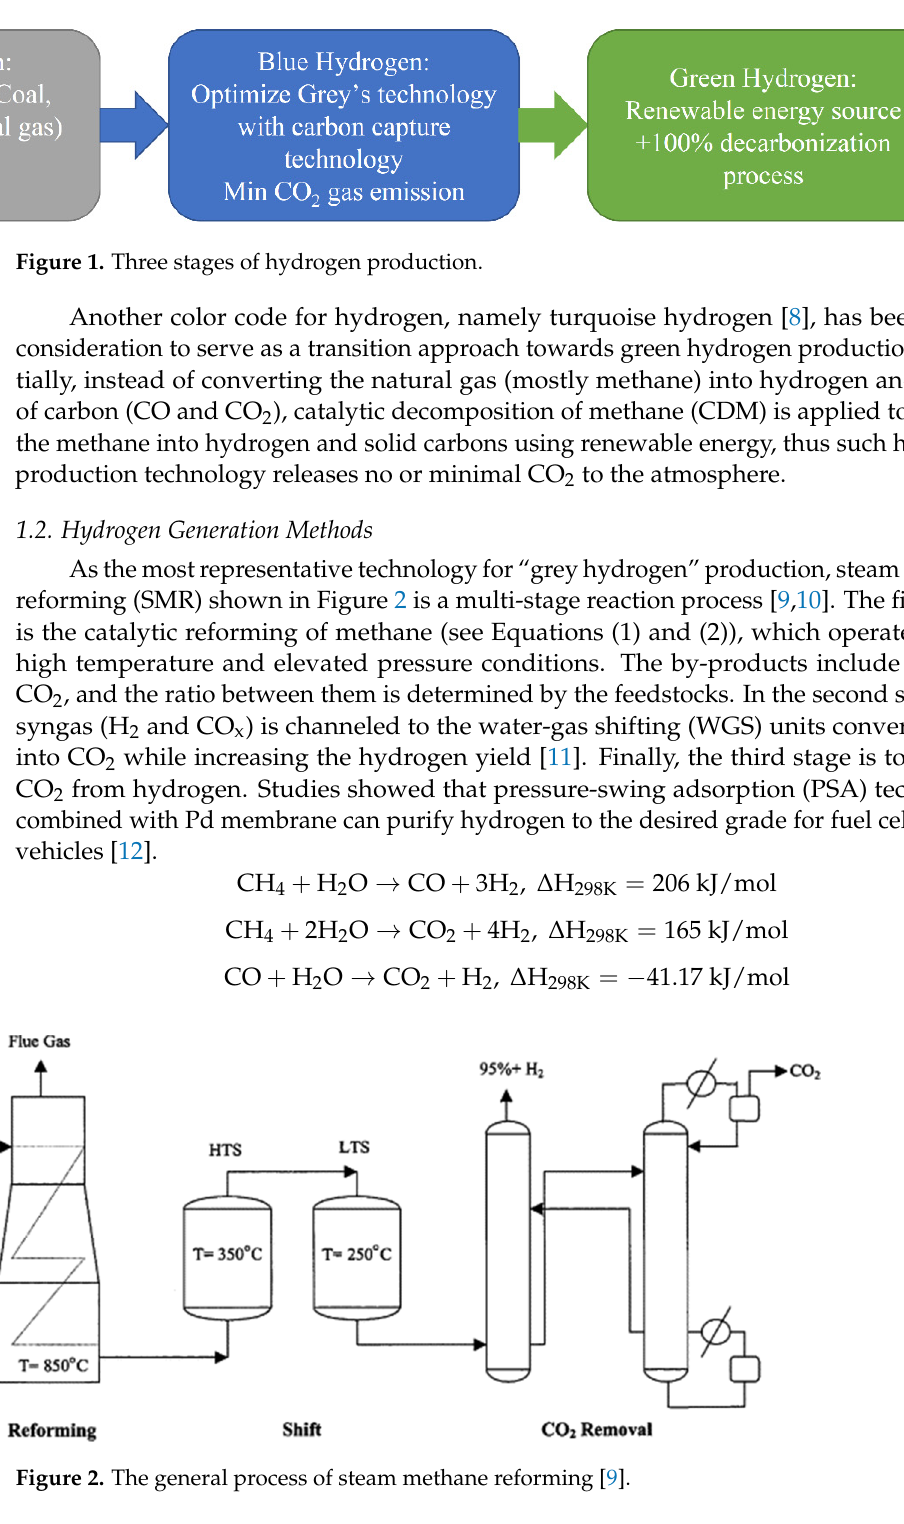
Figure 2. The general process of steam methane reforming [9].